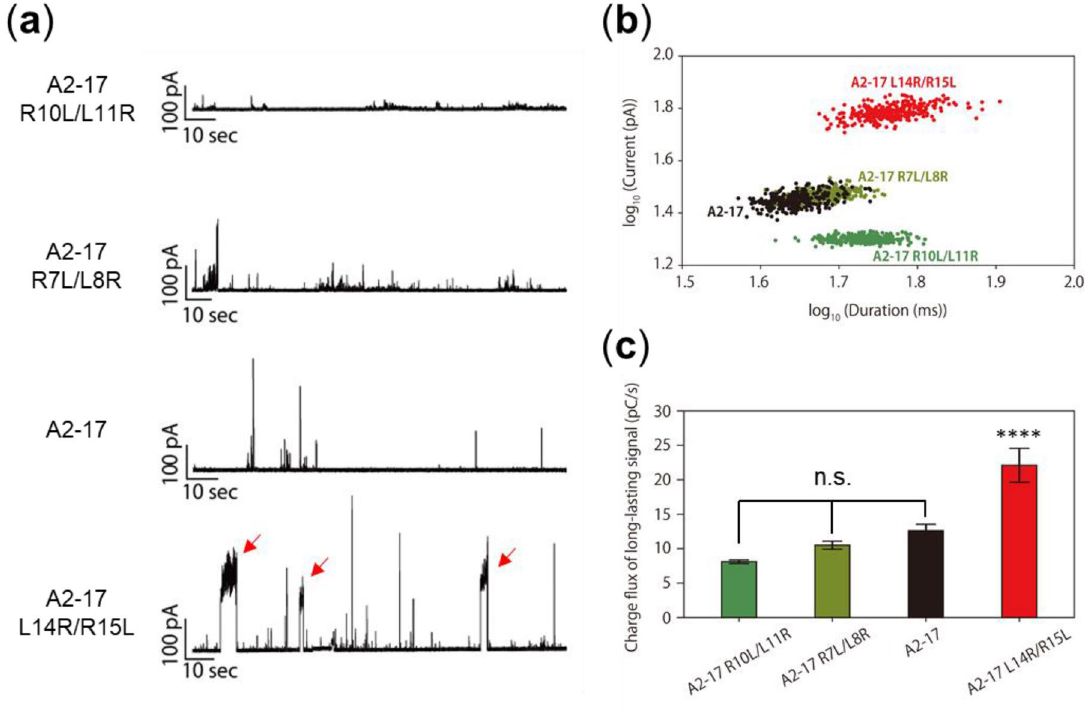
Figure 5. Analysis of the channel current signals of A2-17 structural isomers upon interaction with planar DOPC membranes. ( a ) Typical current and time traces of A2-17 R10L/L11R, A2-17 R7L/L8R, A2-17, and A2-17 L14R/R15L. A pattern of spike current signals with high current values was observed for A2-17, whereas A2-17 L14R/R15L showed long-lasting current signals even with second-order duration as indicated by arrow. The concentration of peptide was 100 nM and the calculated molar ratio of lipid on the droplet surface to peptide was ~ 67 (see the Methods for more detail). ( b ) Plot of current versus duration of long-lasting (stable pore) signals caused by A2-17 R10L/L11R (dark green), A2-17 R7L/L8R (light green), A2-17 (black), and A2-17 L14R/R15L (red). ( c ) The charge flux of long-lasting signals caused by peptides. **** p < 0.0001, compared with A2-17 R10L/L11R. n.s., not